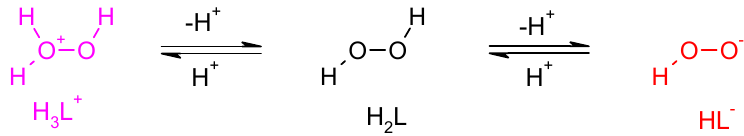
Figure 5. Dissociation/protonation equilibria of dihydrogen dioxide.